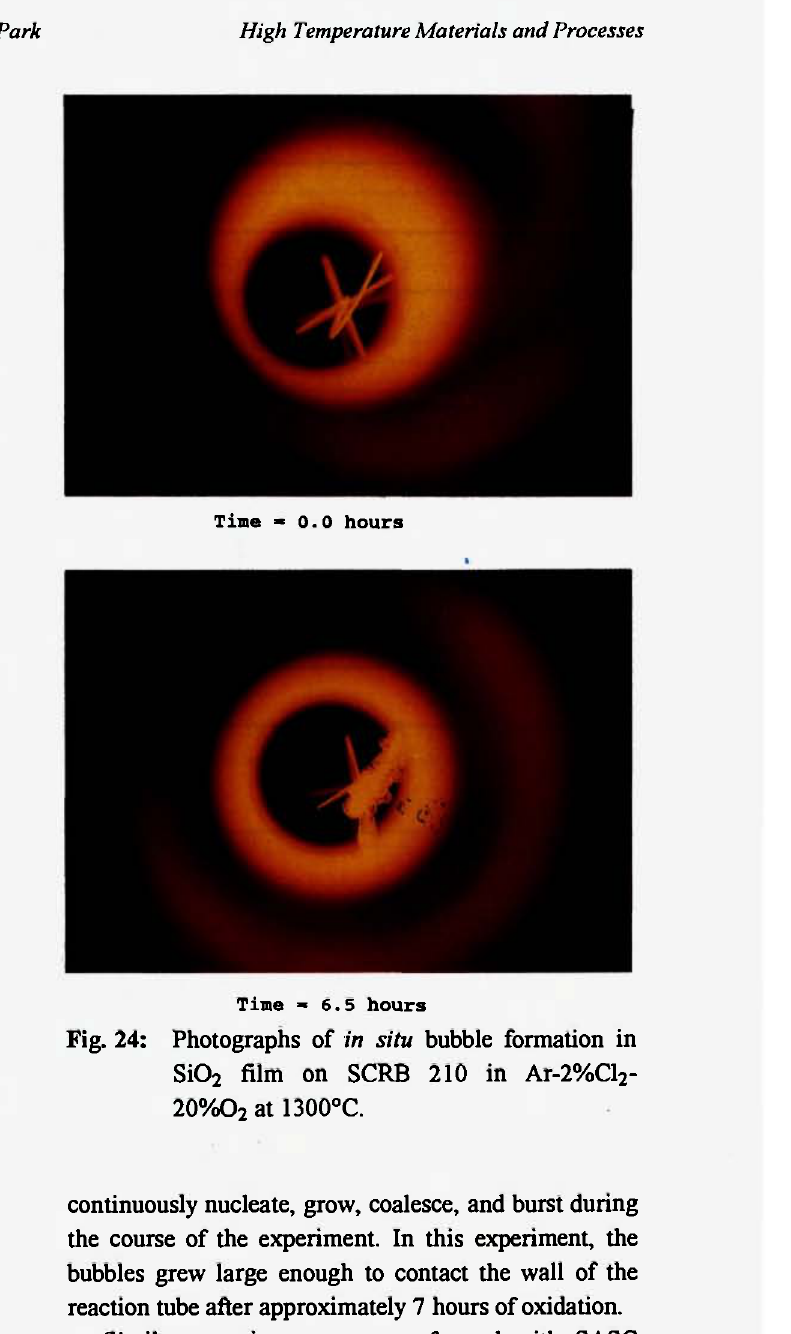
continuously nucleate, grow, coalesce, and burst during the course of the experiment. In this experiment, the bubbles grew large enough to contact the wall of the reaction tube after approximately 7 hours of oxidation. Similar experiments were performed with SASC and C-600 material. Figure 25 shows an example of the bubbles formed on SCRB 210. Scanning electron microscopy on siliconized silicon carbide specimens exposed at lower temperatures showed that the interfaces between the SiC grains and the free silicon phase served as nucleation sites for bubble formation. Because there were many such nucleation sites on the Fig. 23: Scanning electron micrograph of bubbles in surfaces of the siliconized silicon carbide, a large S1O2 film on SASC formed during oxidation number of small bubbles formed on the surface of in Ar-2%C1 -20%02 at 1100°C. 2